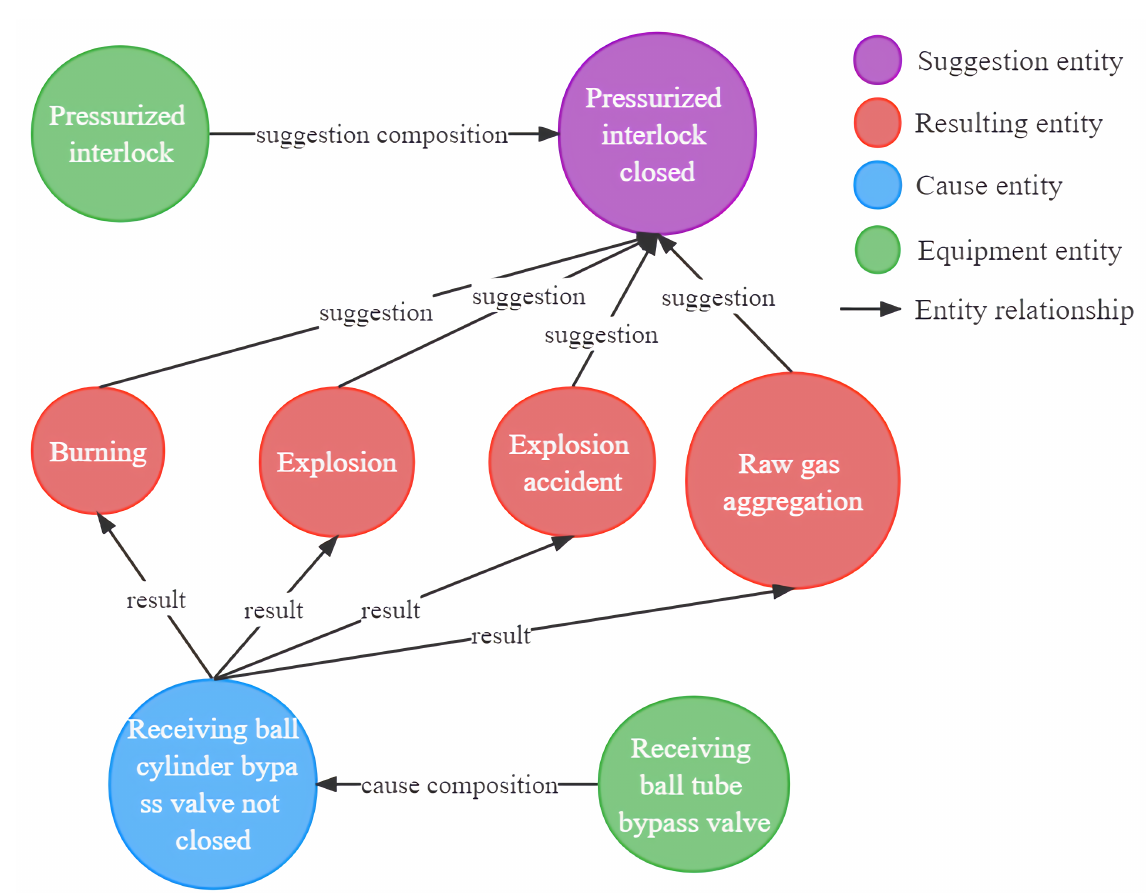
Figure 6. Content and structure display of safety knowledge map of oil and gas inbound module.